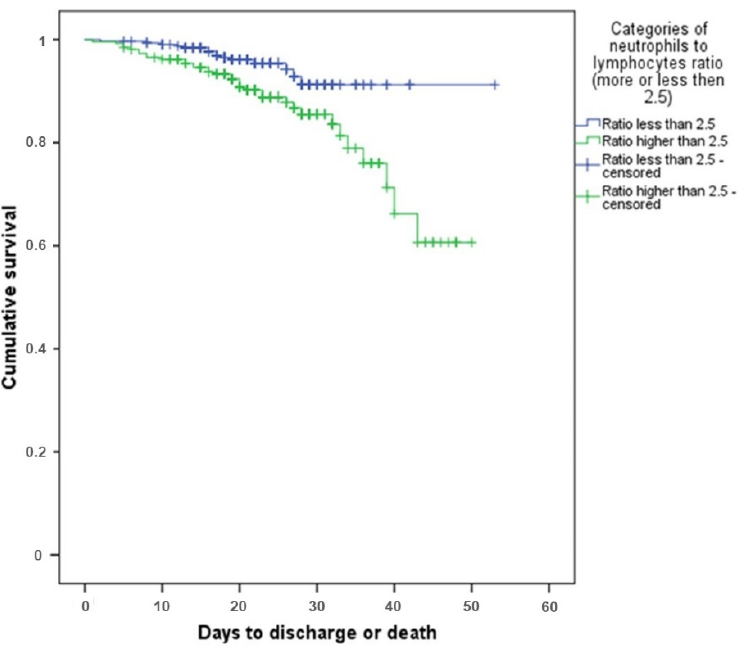
Figure 2. Survival rate in patients’ groups depending on NLR. Blue line represents survival of patients with NLR less or equal than 2.5, green line—patients with NLR more than 2.5. Among patients in the recovered group, the median of this ratio was also lower than in the group of patients with a fatal outcome—2.13 [IQR 0.97; 3.76], and in those who died-4.19 [IQR 1.04; 3.91]. These results are graphically presented in Figure 3.